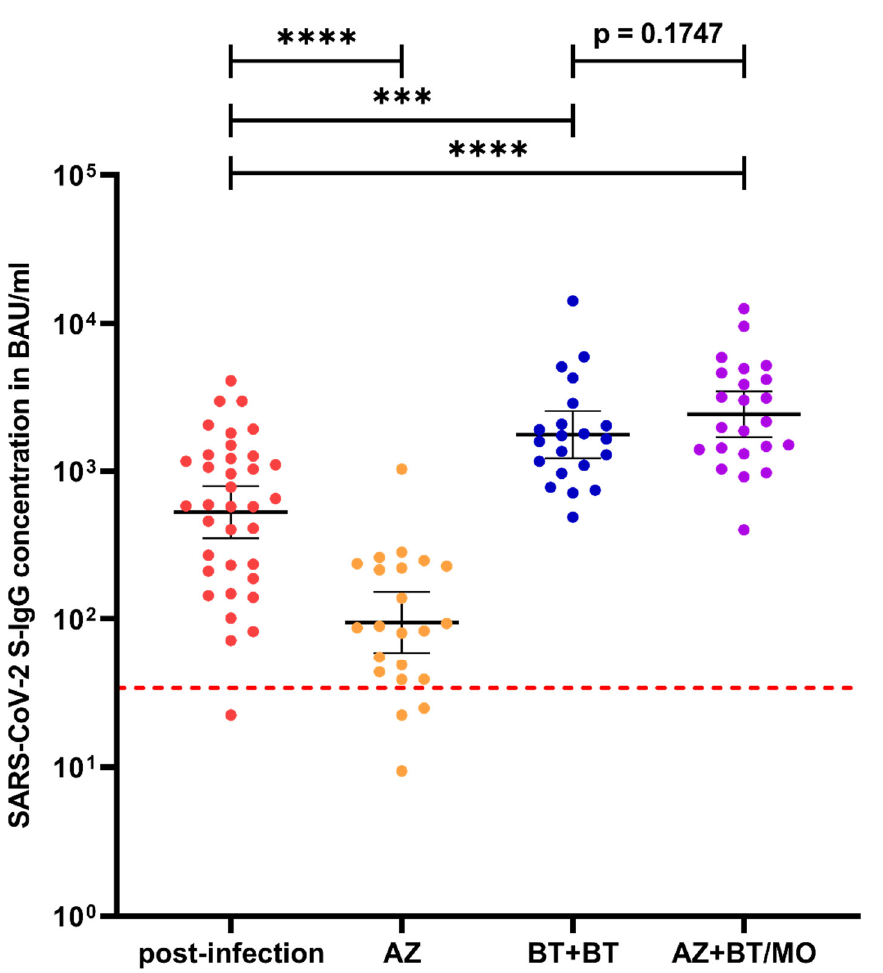
Figure 2. Comparison of S-IgG antibody concentrations about seven weeks post-infection (red), five weeks after prime vaccination with AZD1222 (orange) or BNT162b2 (=two weeks after homologous booster vaccination, blue), and four weeks after heterologous booster vaccination (purple). Red dotted line = manufacturer’s positive cut-off at 33.8 BAU/mL. Abbreviations: AZ = AZD1222, BT = BNT162b2, MO = mRNA-1273. Significance levels: *** p value < 0.001, **** p value <0.0001.